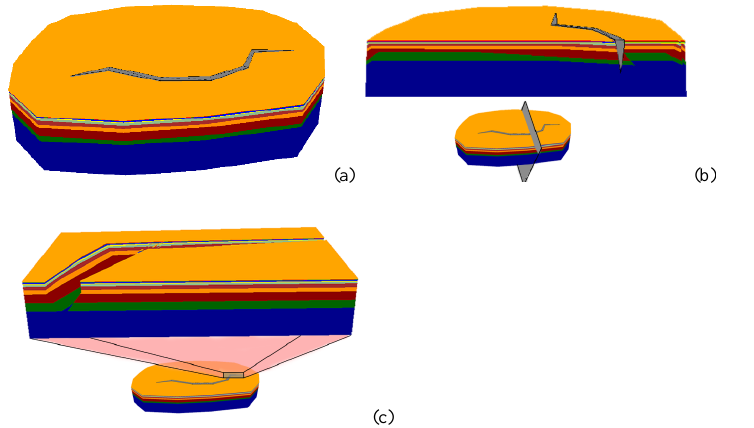
Figure 2. Geologic structure with earth fissure model. (a) The geological body with earth fissures model. (b) The spatial relations between the strata and the fissures. (c) The combination of bottom part of (b) and a close-up of the